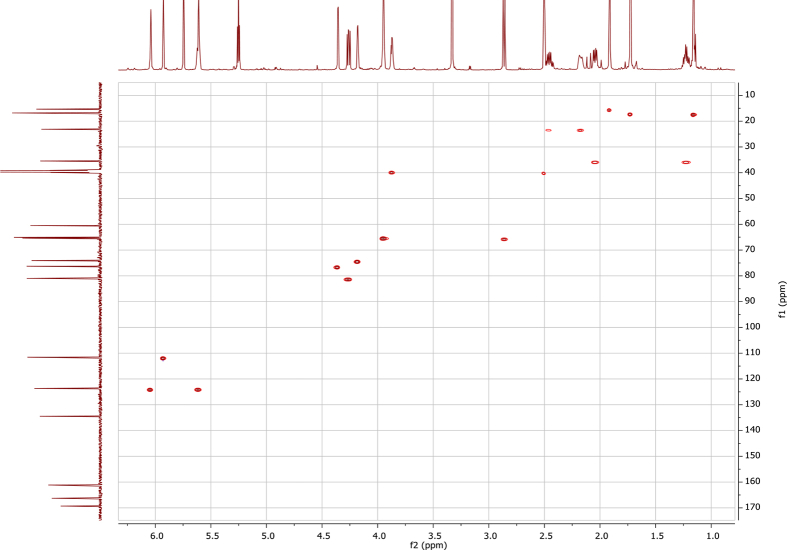
HSQC NMR (DMSO-d6) spectrum of compound 5.